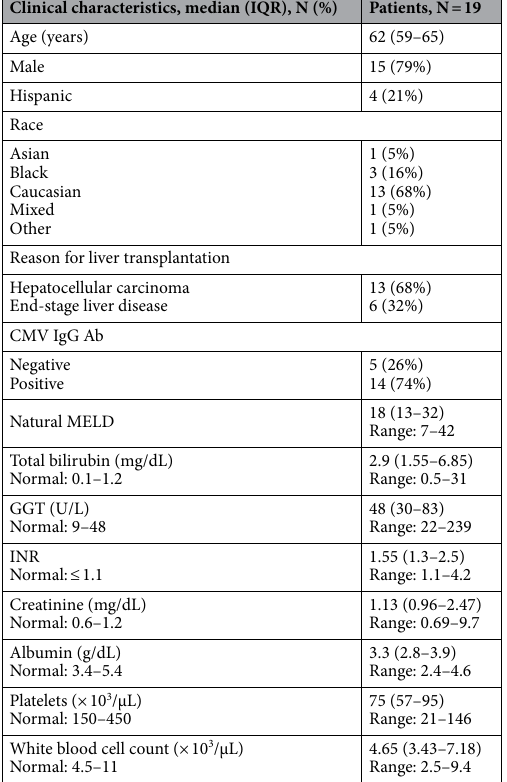
these cells contribute significantly to intrahepatic IFNγ production. LMCs incubated in media (with no TLR stimulation) secreted more of this anti-fibrotic cytokine than PBMCs (Fig. 5B), which may reflect the higher concentration of HCV RNA in liver tissue. These results suggest that liver resident NK cells may restrain liver fibrogenesis through the constitutive expression of IFNγ 23,24 . CD56 Bright CD16 - NK cells are uniquely correlated with indicators of better liver function. We next examined the relationship between the prevalence of each of the sixteen innate immune cell populations (eight in LMCs and eight in PBMCs) and seven indicators of chronic liver disease severity. This analysis was possible because our study group included patients with a spectrum of liver disease severity: MELD scores ranged from 7 to 42, total bilirubin concentrations ranged from 0.5 to 31 mg/dL, and platelets ranged from 21 to 146 × 10 3 /μL (Table 1). The abundance of only one subset—hepatic CD56 Bright /CD16 - NK cells—correlated with better liver function, as indicated by lower total serum bilirubin values (R 2 = 0.65, p = 0.0002, Fig. 6A) and lower MELD scores (R 2 = 0.28, p = 0.03, Fig. 6B). This association was highly specific for hepatic CD56 Bright / CD16 - NK cells. No other subset of NK cells and none of the subsets of other innate immune cells had a sta- tistically significant relationship with lower bilirubin and/or lower MELD scores. Bilirubin concentration was not correlated with blood CD56 Bright /CD16 - NK cells (Fig. 6C, p = 0.99) or hepatic CD56 Bright /CD16 + NK cells (Fig. 6E, p = 0.21), and MELD scores were not correlated with blood CD56 Bright /CD16 - NK cells (Fig. 6D, p = 0.85) or hepatic CD56 Bright /CD16 + NK cells (Fig. 6F, p = 0.72). In contrast to the hepatic CD56 Bright /CD16 - NK cells, greater abundance of hepatic CD16 + /CD14 - monocytes/ macrophages correlated with higher INR values (R 2 = 0.42, p = 0.007, Supplementary Fig. 1A) and higher MELD scores (R 2 = 0.35, p = 0.016, Supplementary Fig. 1B). Opposite, greater abundance of hepatic CD14 + monocytes/ macrophages correlated with higher total bilirubin values (R 2 = 0.27, p = 0.04, Supplementary Fig. 1C), consistent with published data showing that liver monocytes/macrophages promote liver inflammation 25 . Overall, hepatic CD56 Bright /CD16 - NK cells emerged as the subset most likely to have a protective effect. Single sample gene set enrichment analysis (ssGSEA) was used to investigate the impact of CD56 Bright /CD16 - NK cells on the gene expression signature of surrounding tissue, with the expectation that the signature will be dominated by hepatocytes and the other major types of liver cells (endothelial cells, stellate cells, biliary epithelial